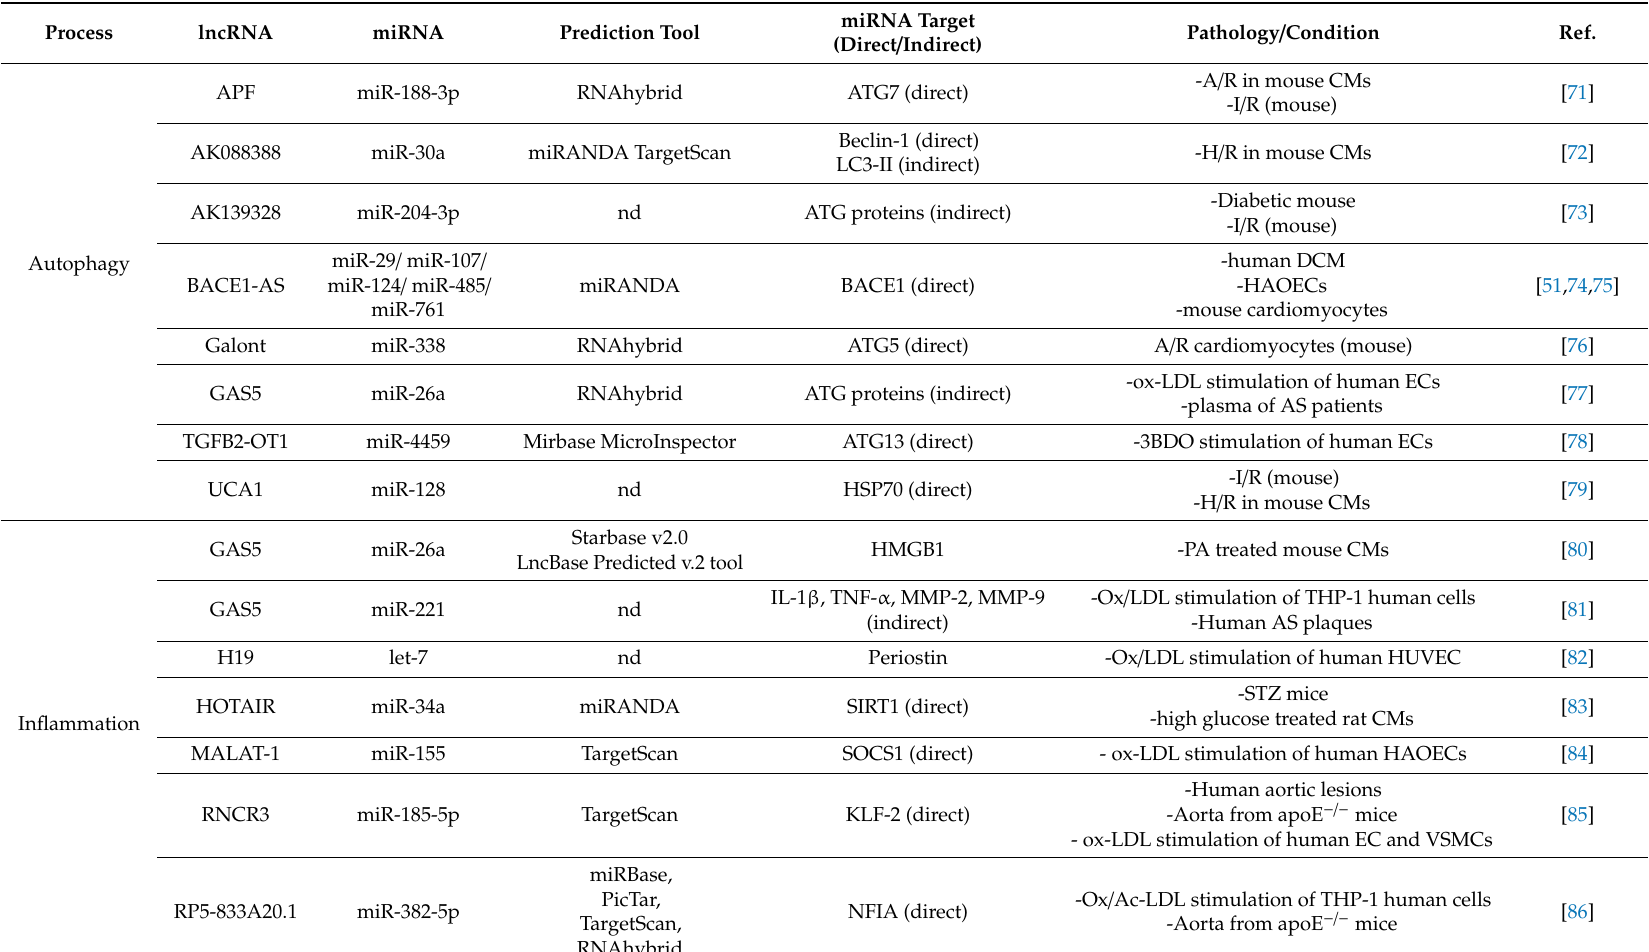
Table 1. LncRNA / miRNA / mRNA networks and ageing mechanisms involved in cardiovascular